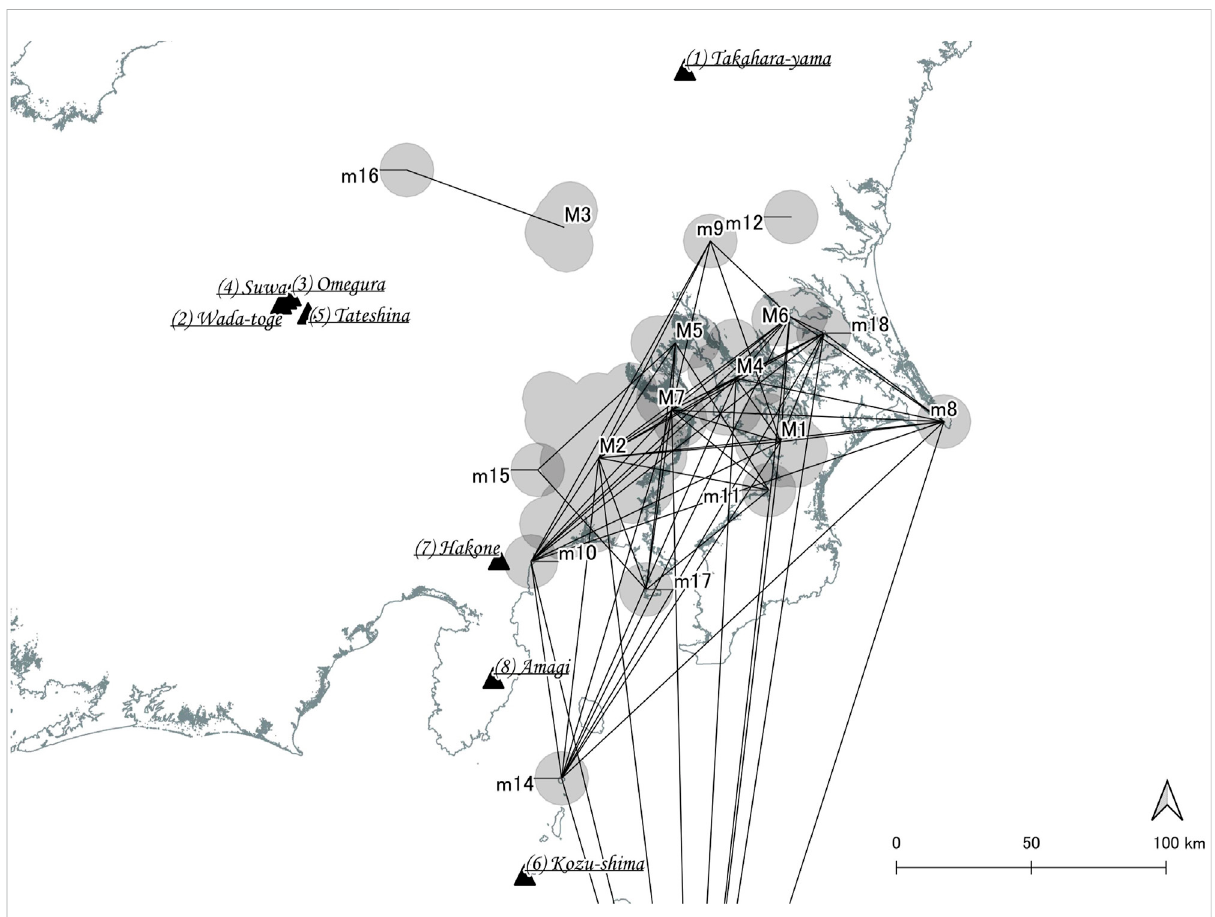
FIGURE 10 Network among consumption areas in Period 3, the middle Jomon period (5,500 – 4,500 years cal BP). Clusters are represented by uppercase characters and single sites by lowercase characters. Pairs with a cosine similarity of more than 0.9 in the composition ratio of each provenance area are